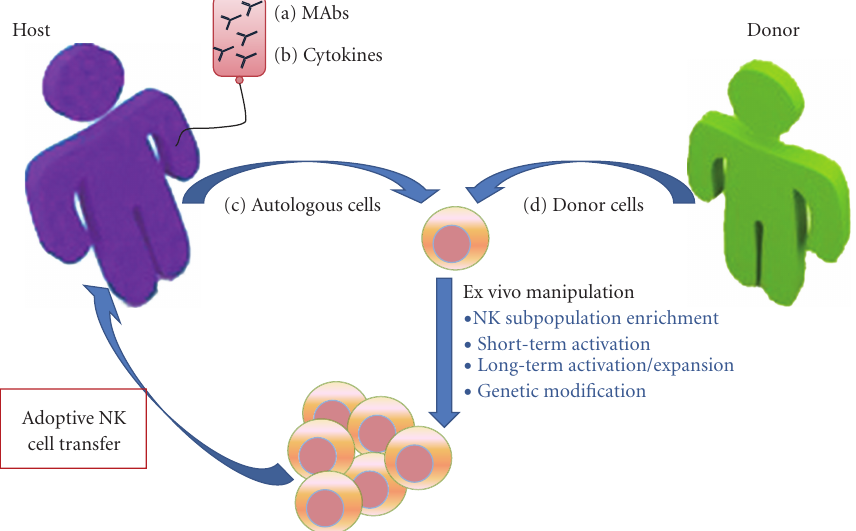
Figure 3: NK cell-based immunotherapies. Overview of current approaches being tested in clinical settings. (a) Infusion of tumor-specific MAbs triggers an ADCC response. (b) ADCC can be potentiated with the coadministration of cytokines. (c) Autologous and (d) allogeneic transfer of NK cells, which can be manipulated ex vivo with di ff erent